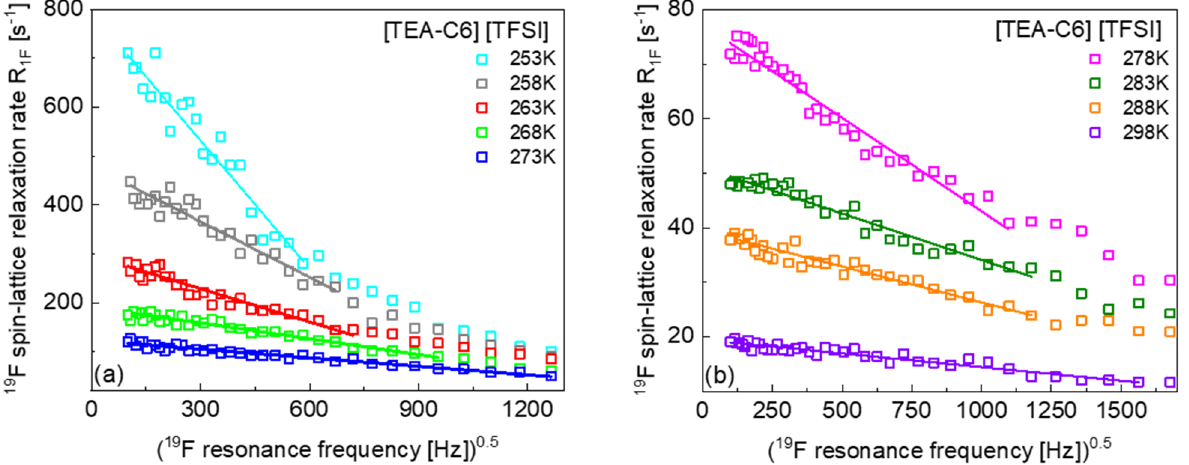
Figure 2. 19 F spin-lattice relaxation data for [TEA–C6] [TFSI] versus the squared root of the reso- nance frequency; solid lines represent linear fits in the low frequency range.